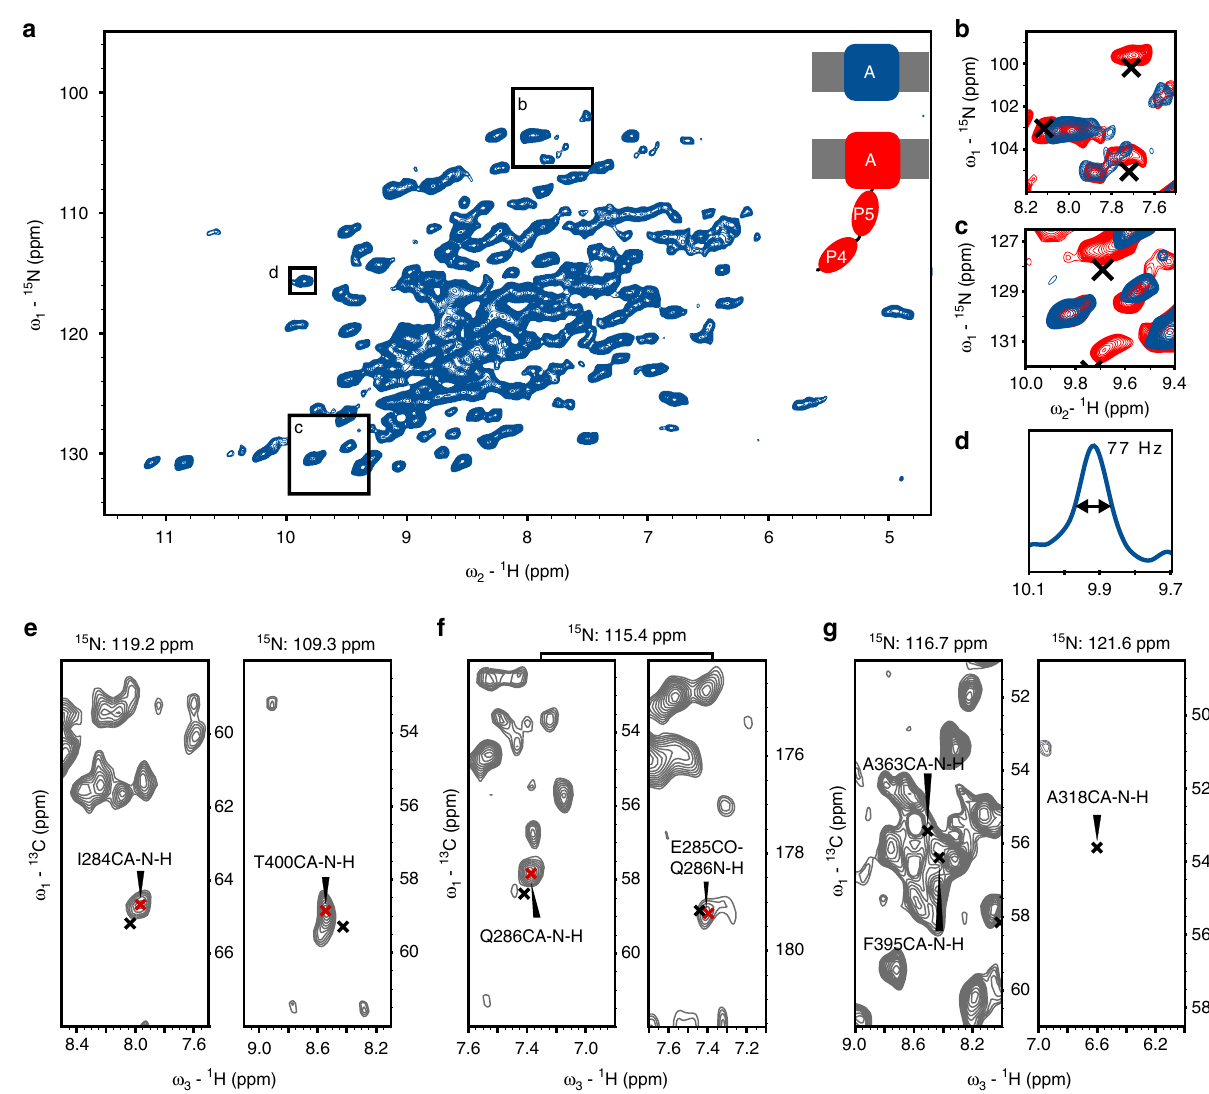
Fig. 1 2D and 3D 1 H ssNMR of BamAP4P5 and BamA TM in proteoliposomes. a 1 H detected 2D NH spectrum of BamA TM in liposomes. Close-ups of b and c show correlations for the POTRA domains. d Representative 1 H line-width extracted from a . e Representative 2D slices from a 3D C α NH experiment that show correlations for residues I284 and T400 which are within 1 ppm in all three frequencies from the solution NMR assignments. f Sequential assignment of the E285/Q286 pair based on solution assignments and ssNMR 3D C α NH and CONH spectra. g From a C α NH experiment in a region of spectral overlap, A363/F395, or e.g. A318 that does not agree with the ssNMR data. Inset in a is a representation of the protein constructs used. In all panels red crosses are ssNMR assignments and in black are solution NMR assignments (BMRB 19928). In g , the 15 N resonance frequencies of the relevant 2D planes are